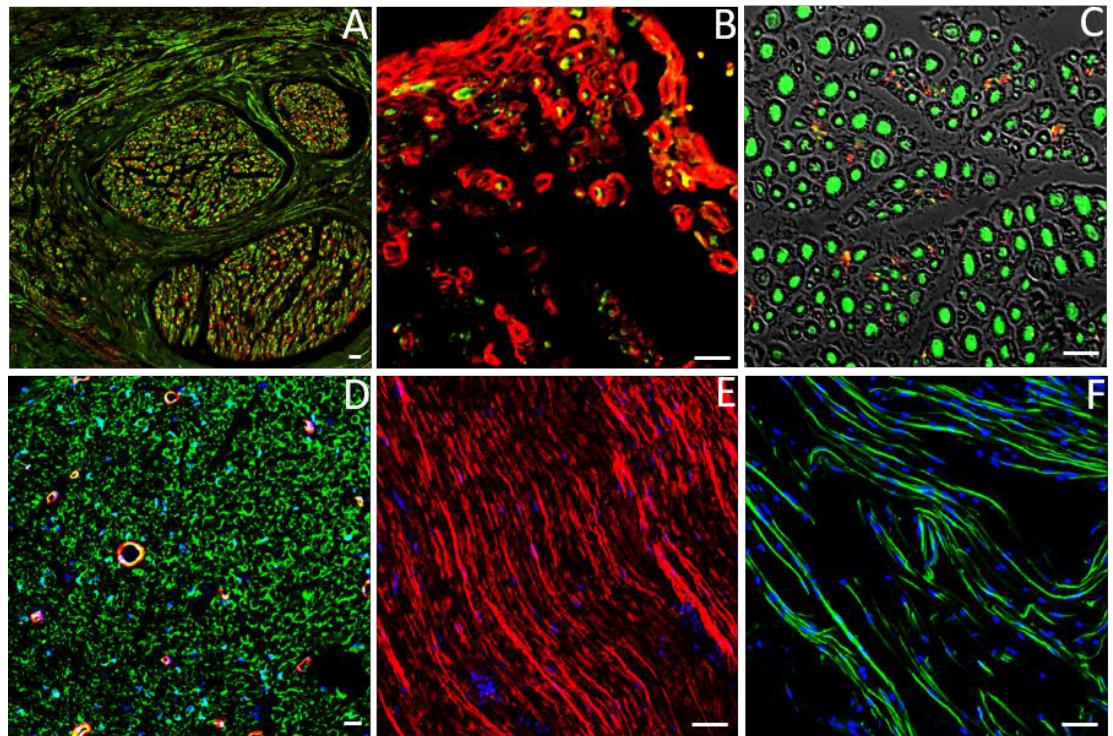
Figure 4. Representative transversal ( A – D ) and longitudinal ( E , F ) sections showing immunolabeled nerves. ( A ) transversal cross section of rat median nerve in which axons are labelled with anti NF-200 (green) and Schwann cells are identified with anti S100 β (red); ( B ) high magnification of a transversal section showing axons labelled with anti NF-200 (green) and Schwann cells with anti S100 β (red); ( C ) high magnification of a nerve cross section immunolabeled with anti- NF-200 (green) and anti-peripherin (red); ( D ) transversal section immunolabeled with anti S100β (green), anti-SMA (Smooth Muscle Actin, red, for vessels), while nuclei are detectable by DAPI (blue); ( E ) longitudinal section showing nerve fiber labelled with anti S100 (red) and DAPI (blue); ( F ) longitudinal section showing axons labelled with anti βIII tubulin (green) and DAPI (blue). Scale bar: 20 μ m.